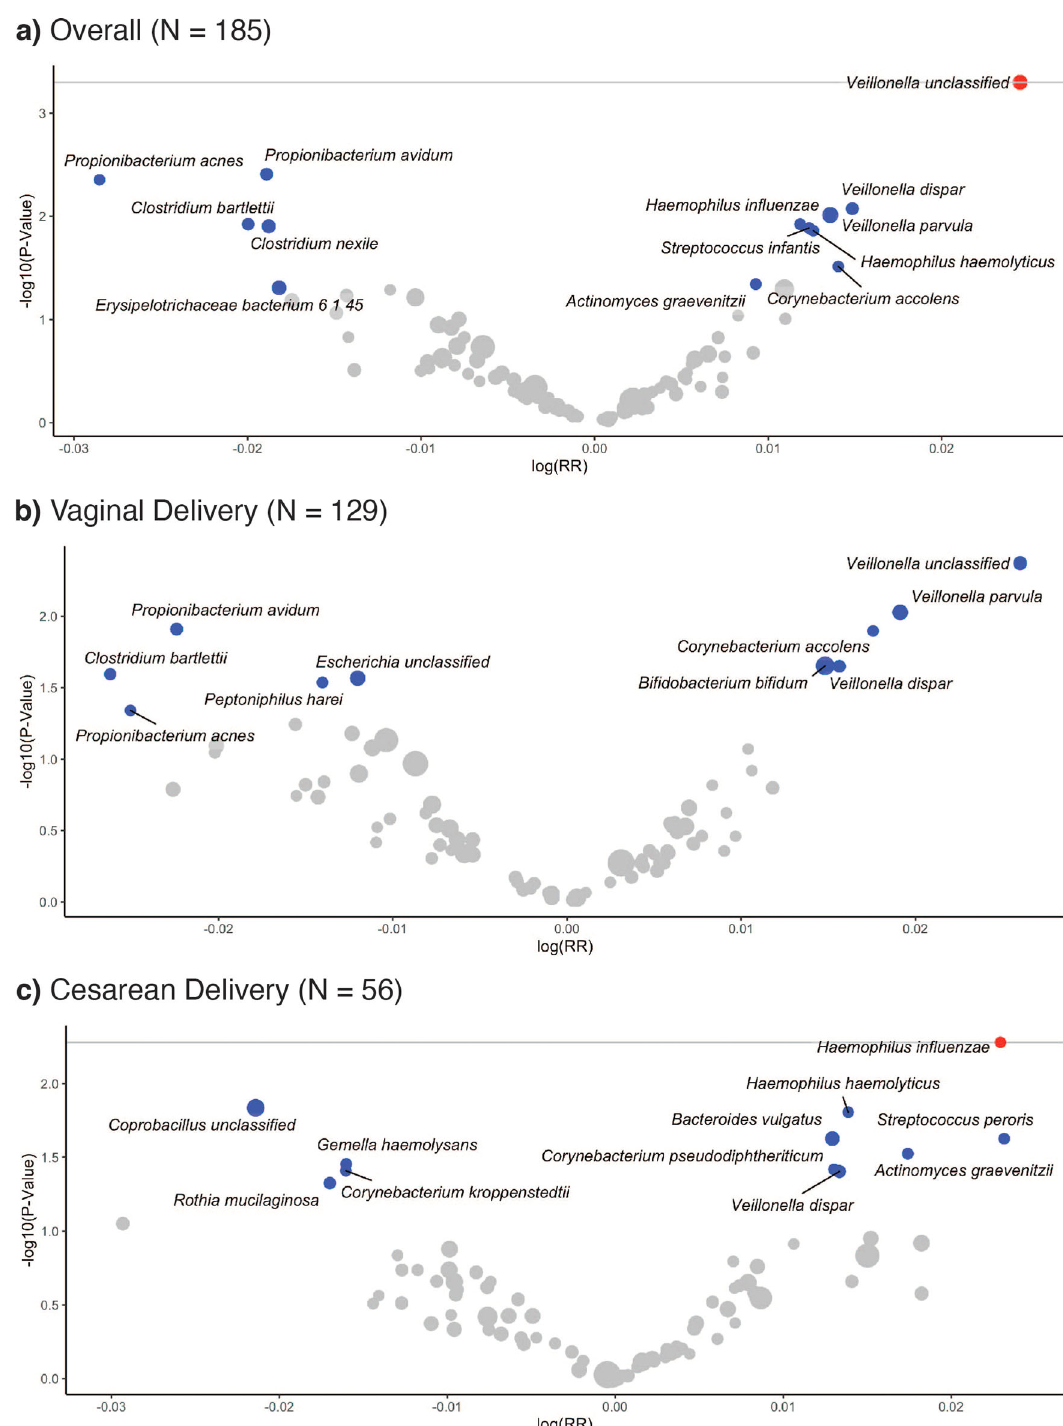
Fig. 2 Volcano plots of GEE adjusted relative risk estimates of the number of infections and symptoms over the fi rst year of life in relation to 6-week metagenomics species relative abundance. Estimates shown for taxa prevalent in over 10% of subjects. The gray line represents a log10-transformed FDR threshold of 0.1. Blue points indicate statistically signi fi cant taxa at α = 0.05. Red points indicate taxa selected by FDR correction. Gray points indicate all other taxa. The size of the points is scaled by relative abundance. Relative risk estimates represent an increased risk of having additional infections or symptoms of infection with each doubling of relative abundance. a Volcano plot of unstrati fi ed GEE adjusted for maternal BMI, delivery type, sex, breast feeding at six weeks, perinatal antibiotic use, and gestational age. b Volcano plot of vaginal deliveries adjusted for maternal BMI, sex, breast feeding at six weeks, perinatal antibiotic use, and gestational age. c Volcano plot of cesarean deliveries adjusted for maternal BMI, sex, breast feeding at six weeks, perinatal antibiotic use, and gestational age. Three taxa were removed due to high RRs and low p -values. GEE generalized estimating equation, N sample size, RR relative